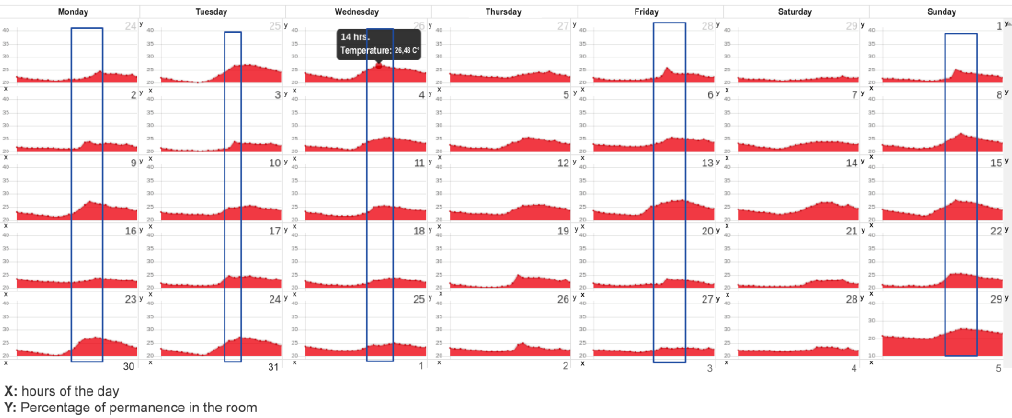
Figure 5. Activity detection representation.